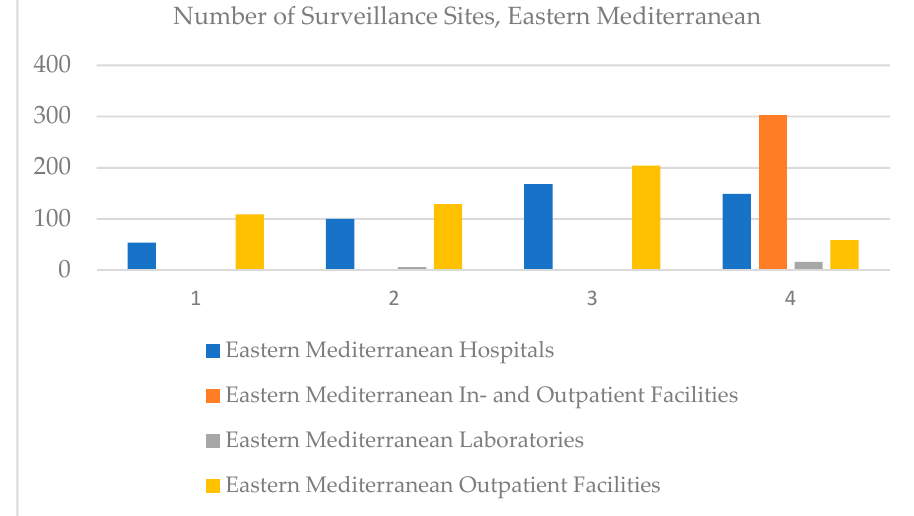
Figure 6. Number of surveillance sites, Eastern Mediterranean, 2017–2020. In Europe, the number of hospitals, outpatient facilities, and in- and outpatients in- creased until 2020, then decreased, and the number of clinical laboratories decreased; however, the highest increase in clinical trials was recorded in Europe (Figure 7).